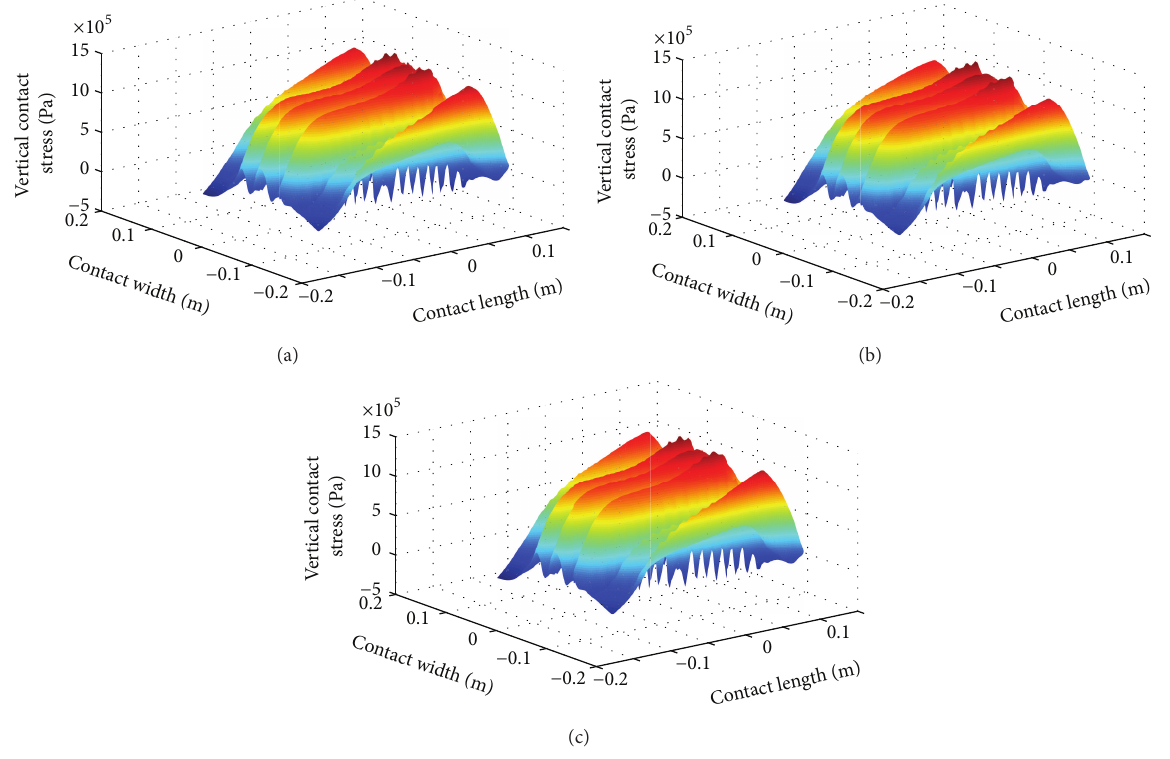
Figure 10: Effects of friction model on vertical contact stress distribution at (a) 𝜇 = 0 . 85, max: 1 . 45 × 10 5 Pa, (b) 𝜇 = 0.7 + 0.15𝑒 −0.5𝑠 , max: 1.43 × 10 5 Pa, and (c) 𝜇 = 0 . 7 + 0 . 15 𝑒 − 0 . 05 𝑠 , max: 1 . 26 × 10 5